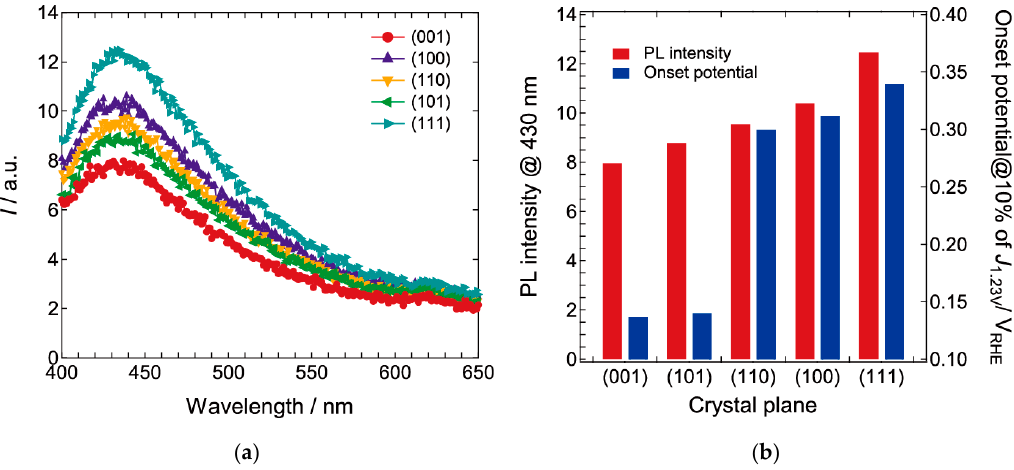
Figure 8. ( a ) PL spectra for the TiO 2 :Nb substrates excited at 350 nm. ( b ) The PL intensity at 430 nm and onset potential defined as the bias voltage at 10% of the photocurrent at 1.23 V RHE for each substrate.